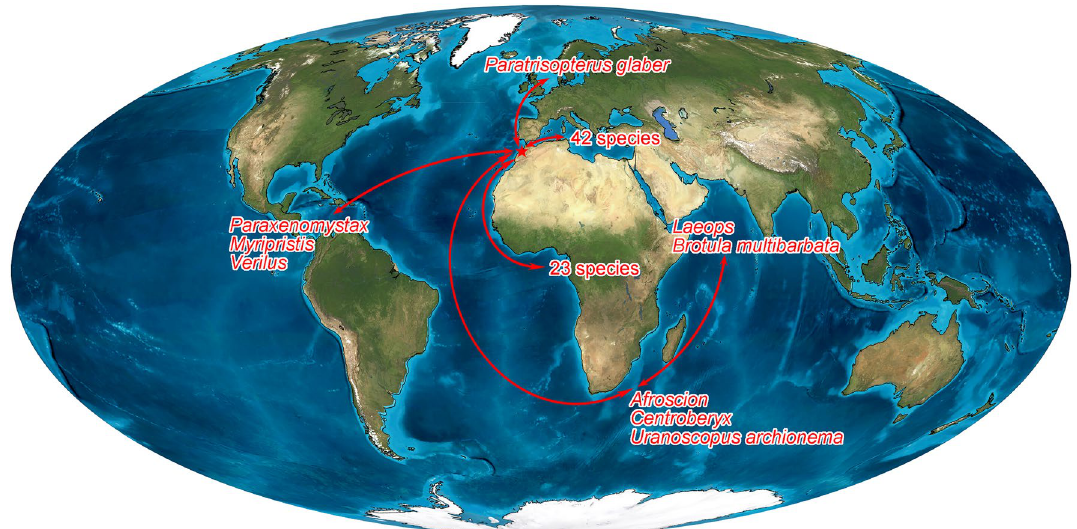
Fig. 31 Biogeographic correlation map showing nearest relationships of Early Pliocene otolith-based taxa from Dar bel Hamri. Red arrows and annotations indicate correlations to extant species also known as fossils from the Rharb Basin and relationships of extinct taxa from the Rharb Basin. Map from Blakey,